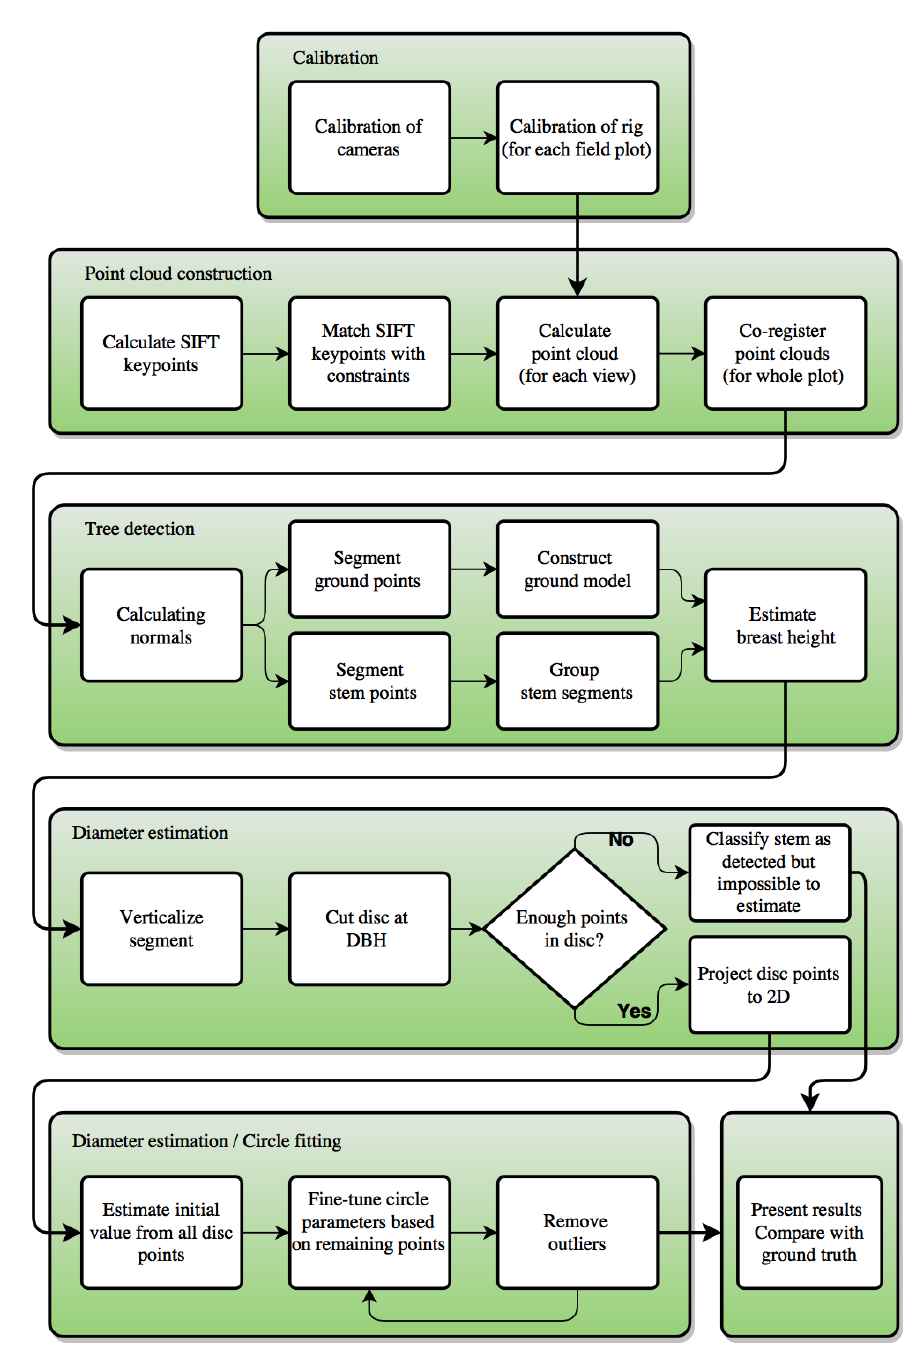
Figure 6. Overview of the data processing